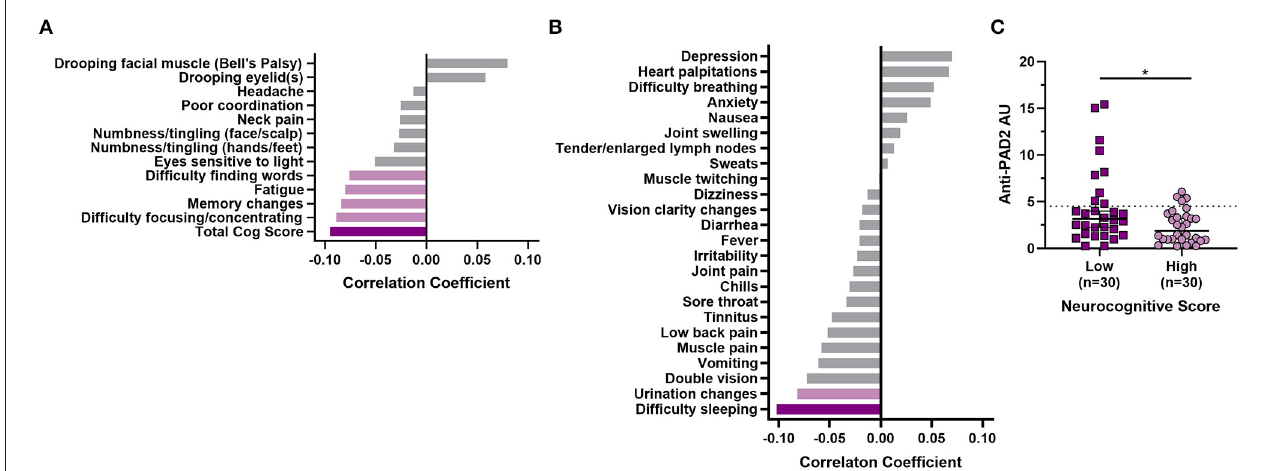
FIGURE 4 | Anti-PAD2 antibody levels in PTLD inversely correlate with symptom severity. (A) A bar graph with the Kendall Tau’s correlation coefficients for symptoms measured by the PLQS that are included in the neurocognitive score are shown. (B) Kendall Tau’s correlation coefficients for symptoms measured by the PLQS that are not included in the neurocognitive score are shown. For (A) and (B) , the dark purple bars indicate symptoms with a significant p ≤ 0.05, the light purple bars indicate those with p ≤ 0.1, and the gray bars indicate symptoms with p > 0.1. (C) Anti-PAD2 antibody levels were compared in demographically matched people with PTLD who had the lowest (score < 5; n = 17; dark purple squares) or highest (score ≥ 17; n = 17, light purple circles) burden of neurocognitive symptoms, as measured by the PLQS. Median anti-PAD2 antibody arbitrary units (AU) were compared by group using the Mann–Whitney U -test. * p <